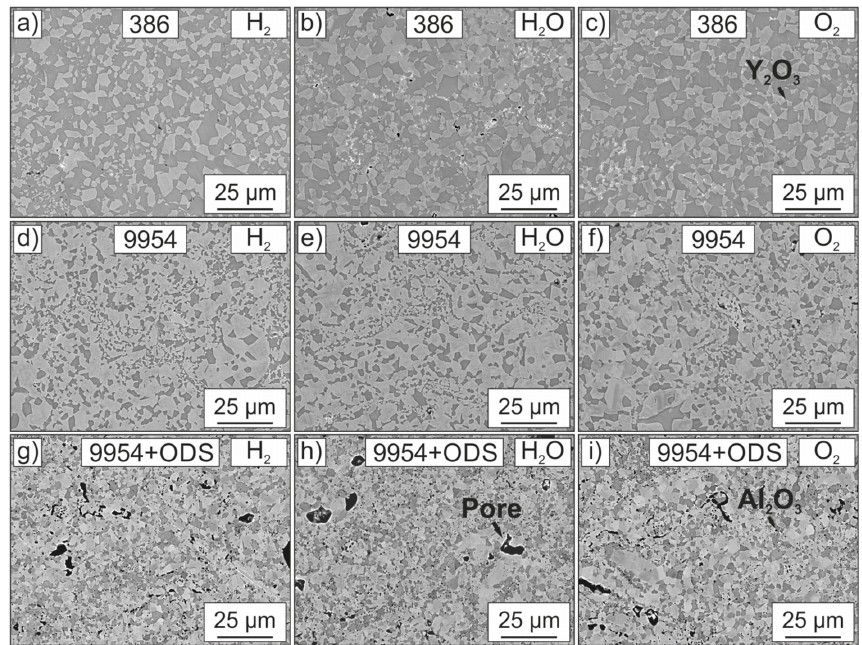
Figure 2. BSE (backscattered electron) images of the microstructures of Amdry 386 ( a – c ), Amdry 9954 ( d – f ) and Amdry 9954 + ODS ( g – i ) after a heat treatment of 72 h in Argon with the addition of 4% H 2 + 2% H 2 O, 2% H 2 O and 20% O 2 before creep testing.